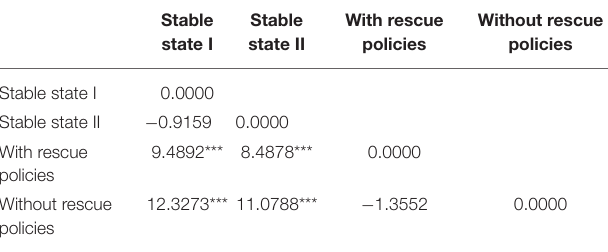
TABLE 2 | Results of t -test for testing the significance of the difference between the entropies of the stock network for different sub-periods in the Shanghai stock